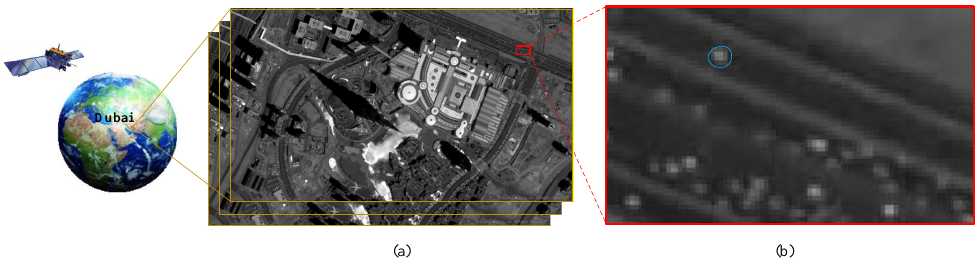
Figure 1. Skybox satellite video sequences. ( a ) is a frame of a skybox satellite video sequences. ( b )